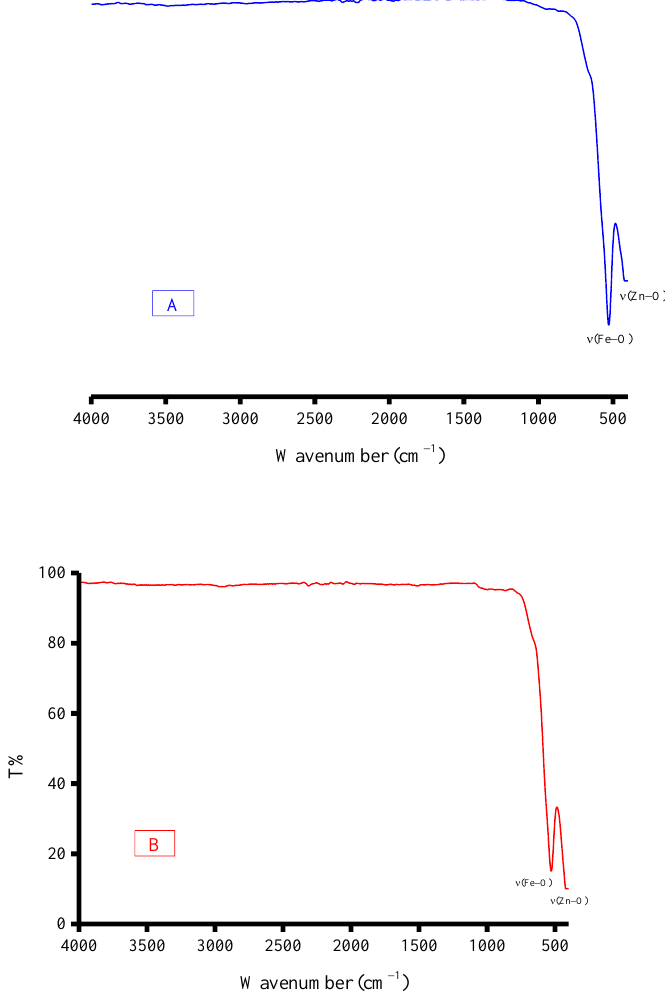
Figure 3. IR spectra of the composites: ( A ) composite 1 ; ( B ) composite 2 .